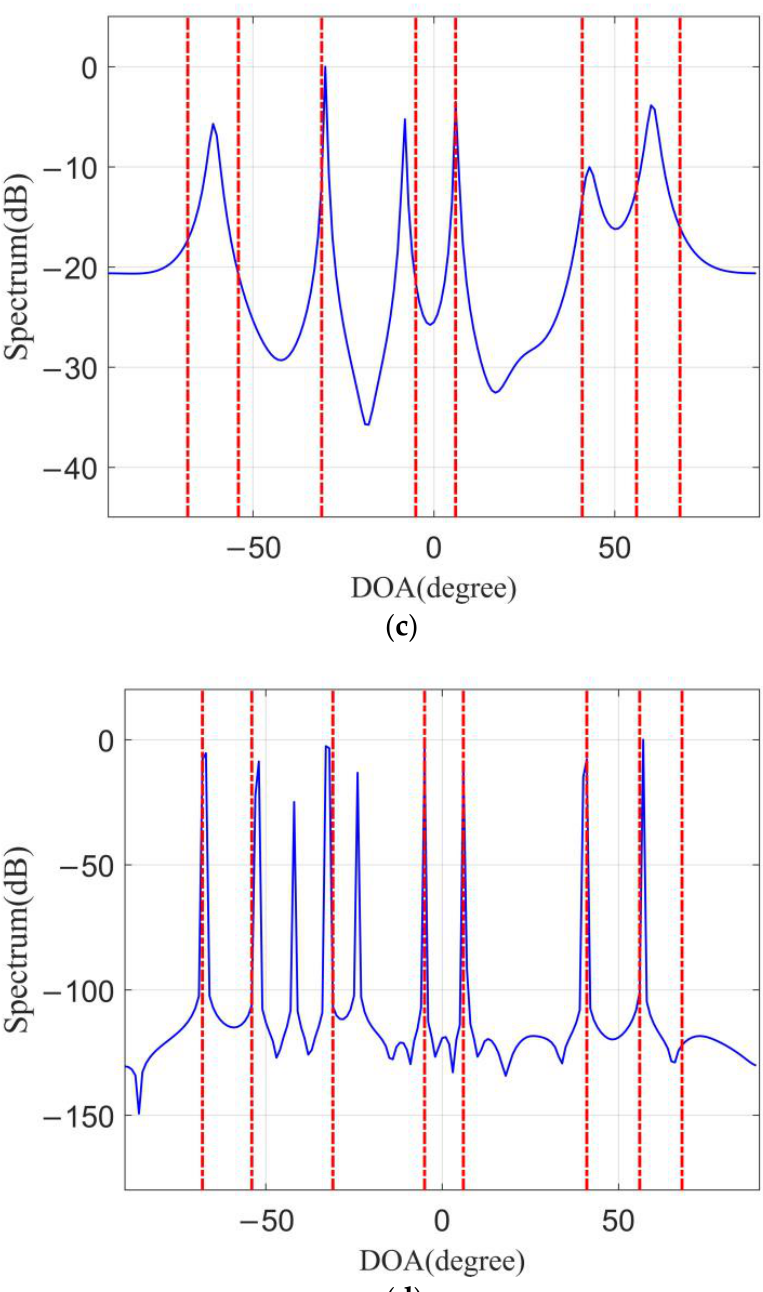
Figure 6. Co-channel interference spatial spectrum estimation, ( a ) Maximum likelihood, ( b ) MUSIC, ( c ) Compressed sensing based on ULA, ( d ) the proposed method.